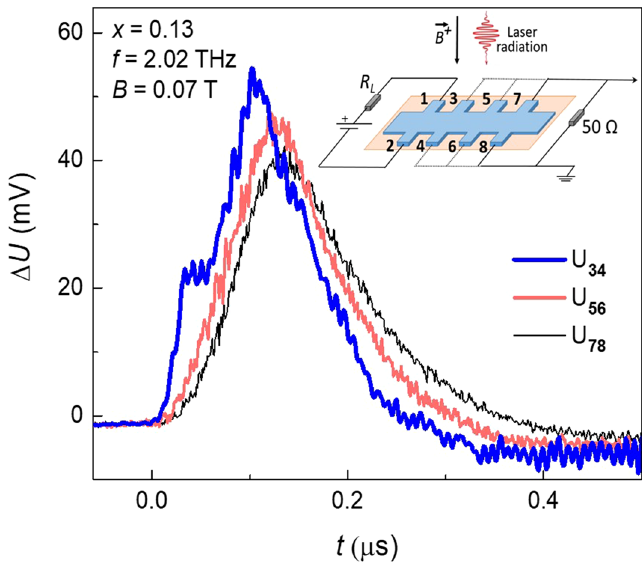
Figure 3. Nonlocal photoresponse probing. Typical photosignal kinetics taken between different couples of the potential leads 3–4, 5–6 and 7–8 while 1–2 are the current leads. The inset shows the experiment geometry. The film composition x = 0.13 corresponds to the topological phase, the magnetic field B + = 0.07 T, the terahertz laser frequency is 2.02